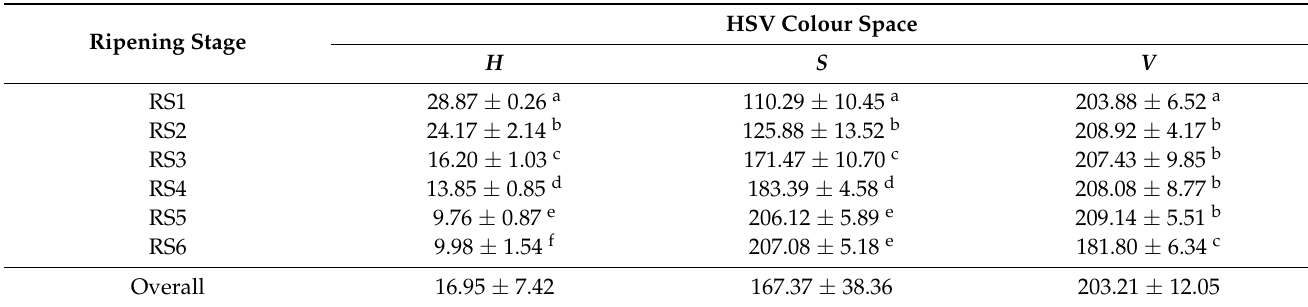
Table 3. Values of HSV (Hue: H , Saturation: S , Value: V ) colour space in strawberry fruits at six stages of ripening.